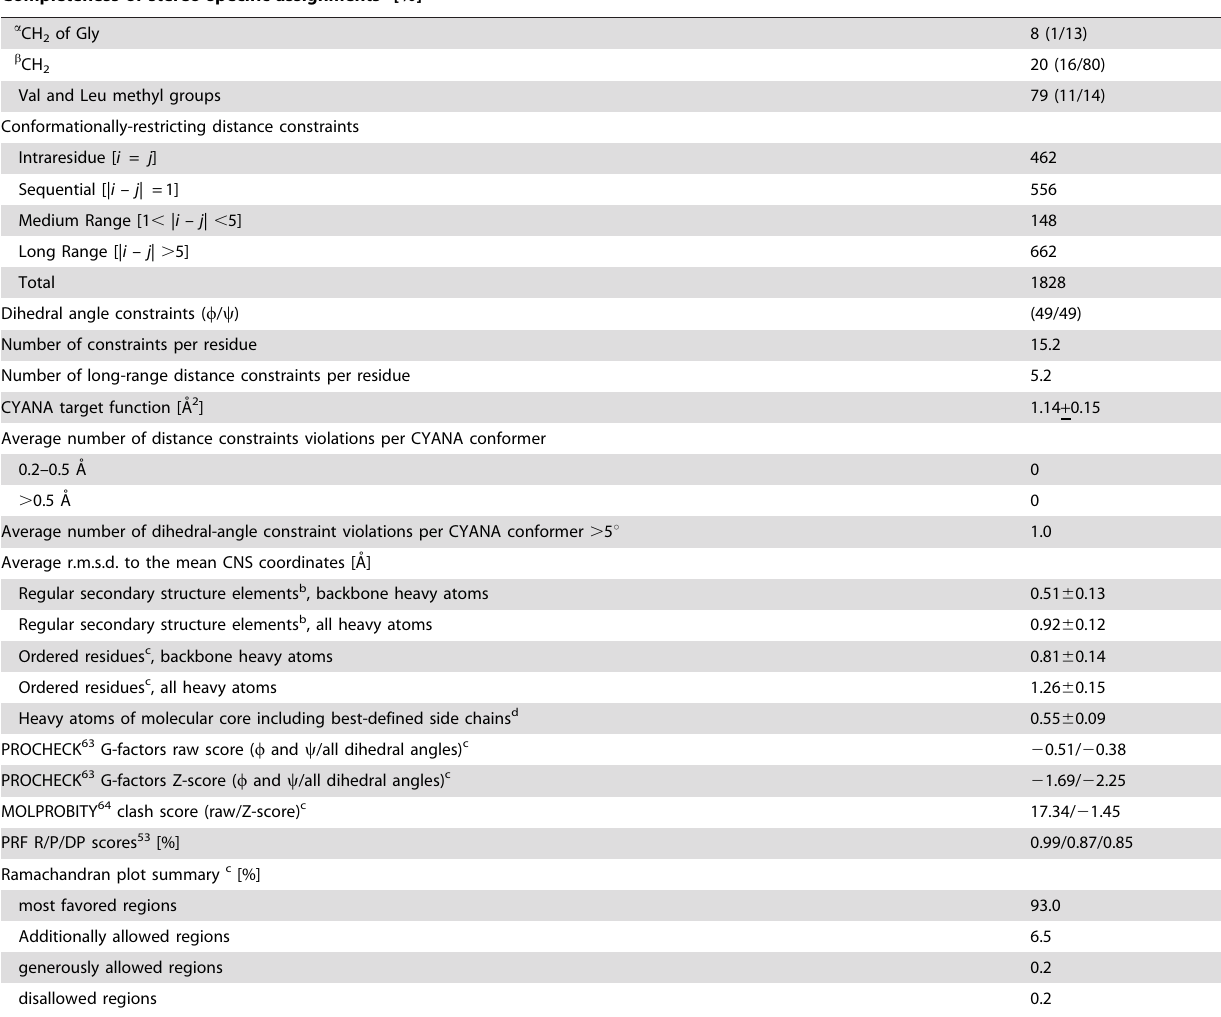
Table 1. Statistics of YxeF(19–144) NMR